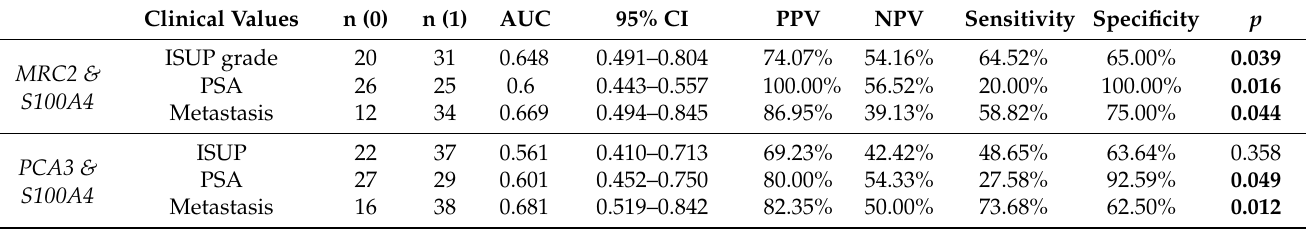
Table 1. Clinical statistical analysis of present